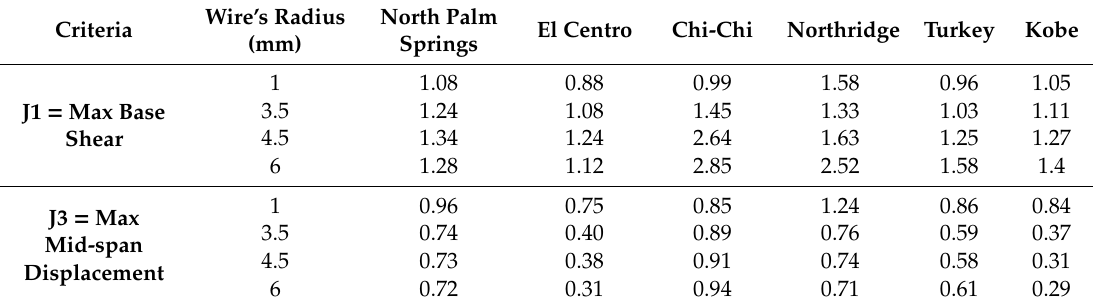
Table 5. Nonlinear dynamic analysis results of the benchmark bridge equipped with di ff erent SMA-LRB